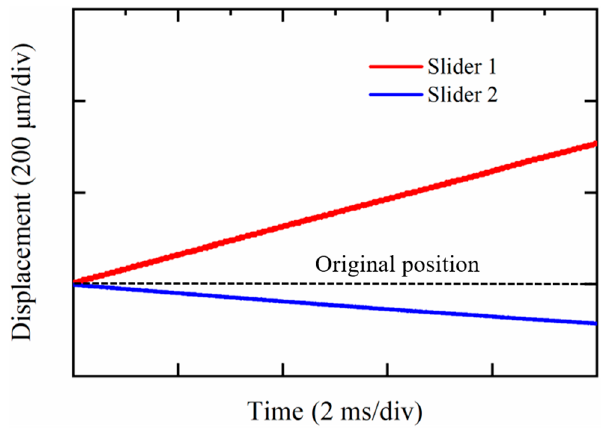
Figure 18. Crosstalk of the Slider 2 in IDM Mode.